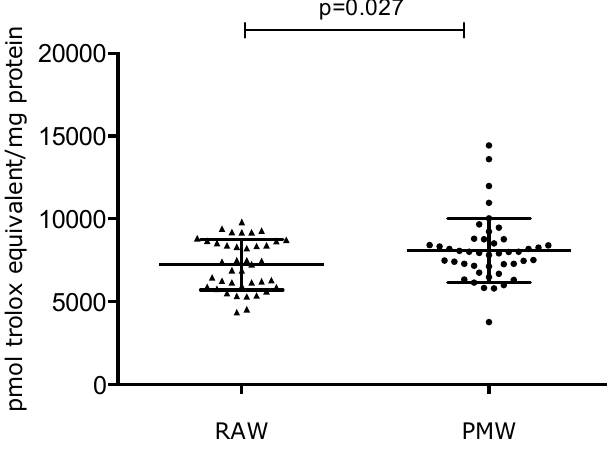
Figure 5. The antioxidant defense evaluated in reproductive-aged women (RAW) and postmenopausal women (PMW).